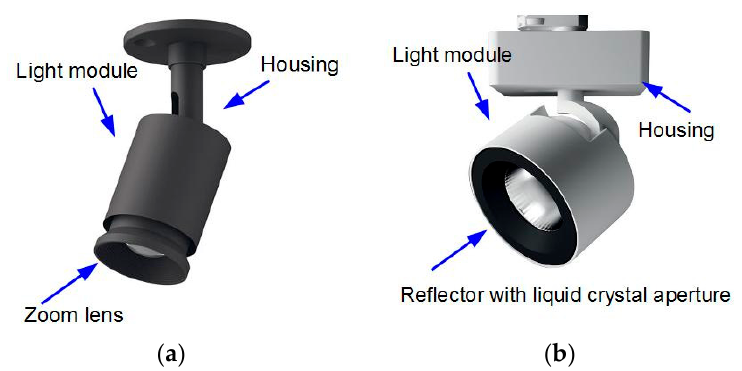
Figure 3. Selected luminaires with variable light beam opening: ( a ) manually controlled zoom lens, ( b ) aperture equipped with electronically controlled liquid crystal glass lenses.